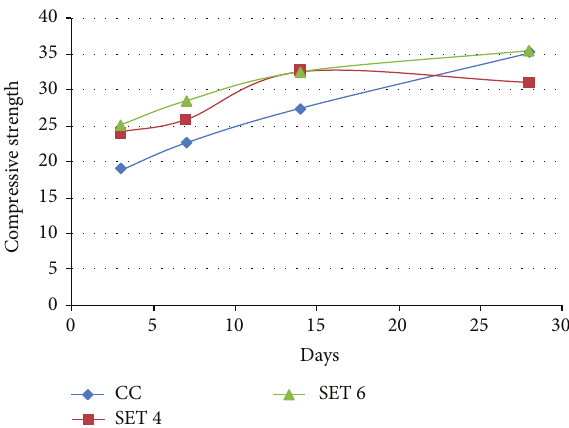
Figure 4: Comparison of control concrete with Set 4 and Set 6.